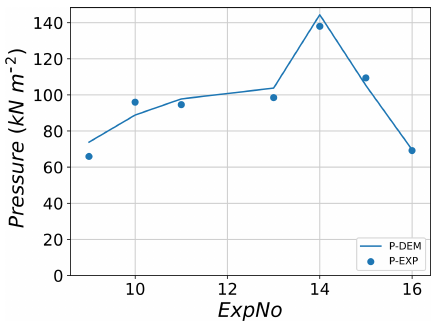
Figure 18. Evolution of the impact pressure on the large plate for test no. 9 and its respective DEM best-fit simulation.